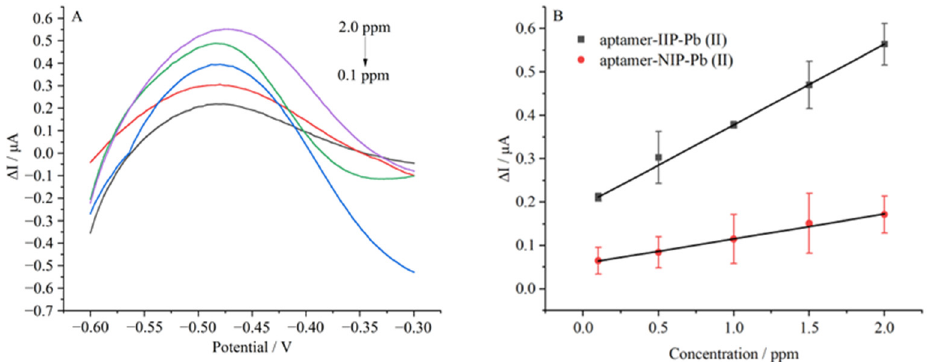
Figure 3. Typical DPV curves ( A ) of IIP-aptamer-Pb(II) in pH 7.4 phosphate buffer with different concentrations of Pb(II), respectively; linear relationship ( B ) between the peak current and the concentration of Pb (II).